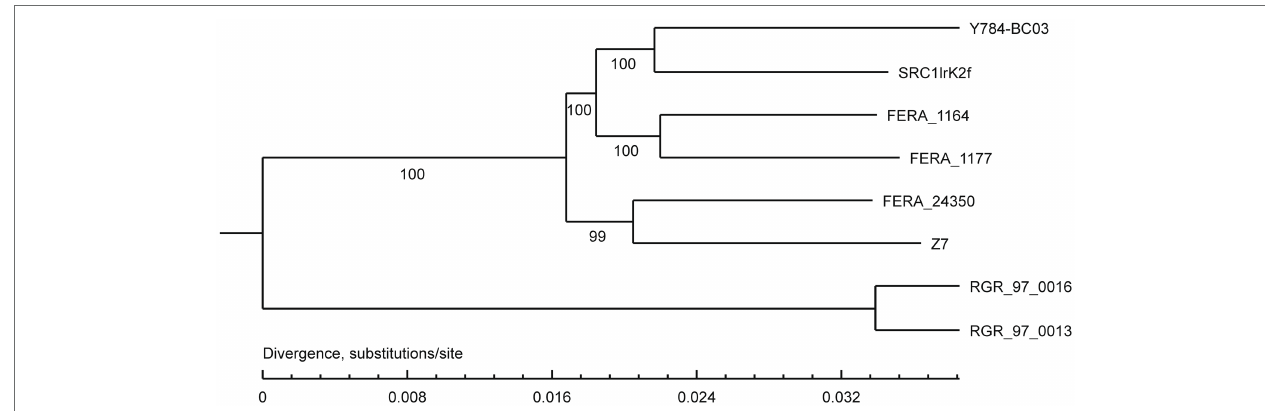
FIGURE 6 | Phylogenetic analysis of A. alternata (Y784-BC03). The neighbor-joining tree was built with RAxML based on maximum likelihood method. Bootstrap values >50% were shown at the nodes. The scale bar represents a genetic distance of 0.1. SRC1lrK2f represents A. alternata isolated from effluent of coal mine drainage; Z7 represents A. alternata isolated from tangerine. FERA 116 4 and FERA 1177 represented A. tenuissima isolated from apple. FERA 24350, RGR 97.0013, and RGR 97.0016 represent non-pathotypes of A. arborescens .